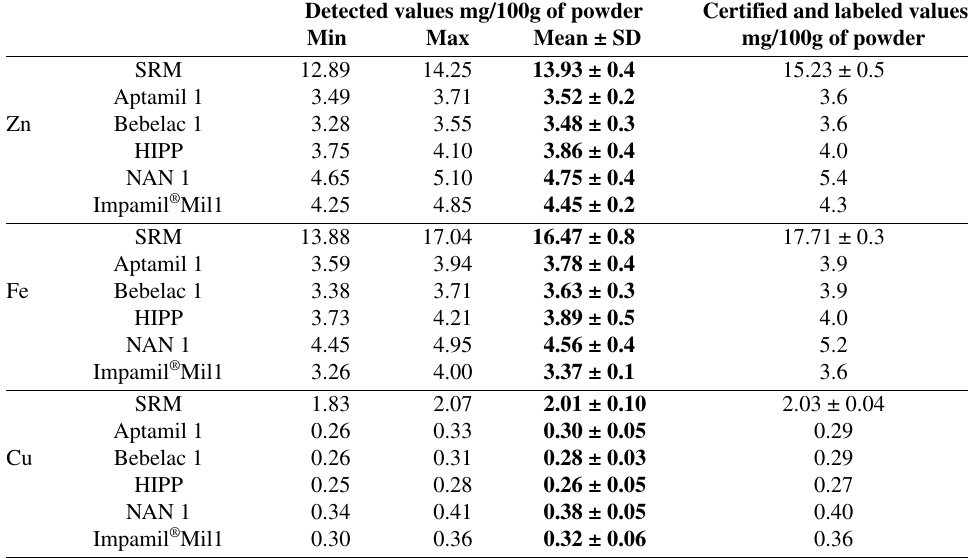
Detected values mg/100g of